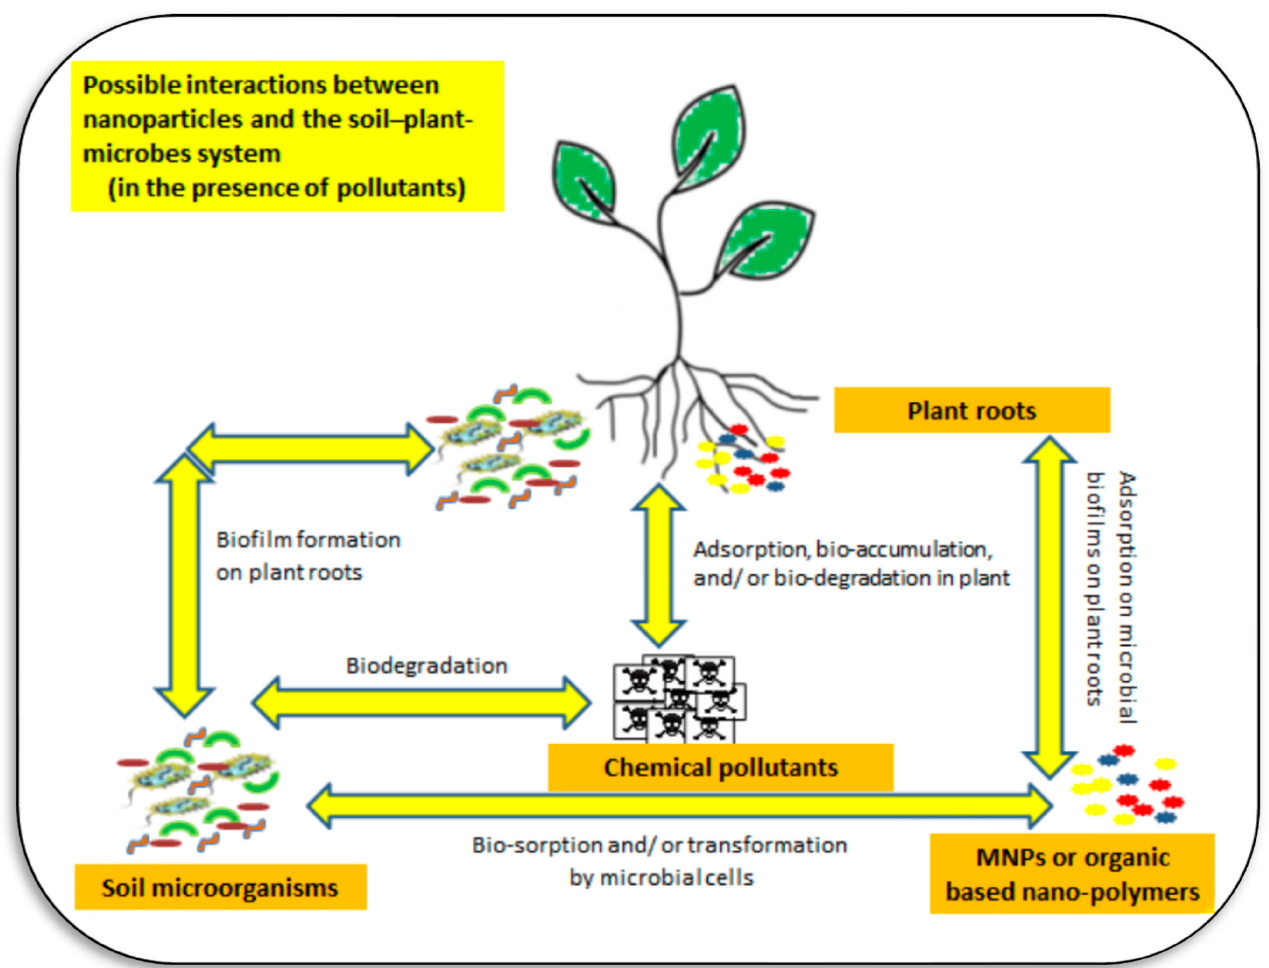
Figure 19. Different soil rhizospheric interactions between plant roots, agrochemicals (mainly min- eral fertilizers and pesticides), organic/inorganic pollutants, soil micro-organisms (bacteria, fungi, actinomycetes, viruses), nanoparticles (NPs)/and or nanomaterials (NMs), and their interactions in the soil solution. Relationships between plants, microbes, and nano-materials during restoration of contaminated soil are still open questions that need more investigation. Sources: [118,122–124].